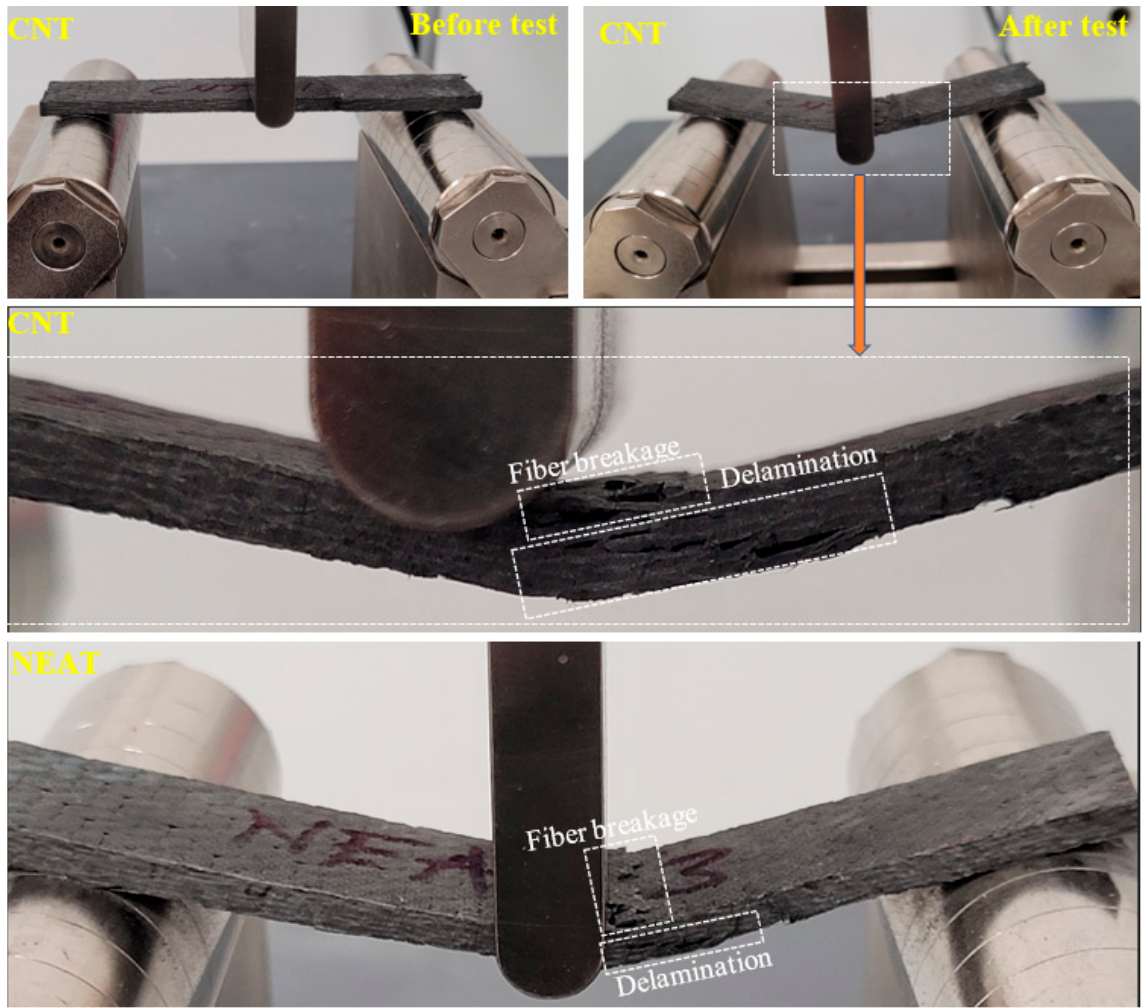
Figure 6. Damage analysis of samples.